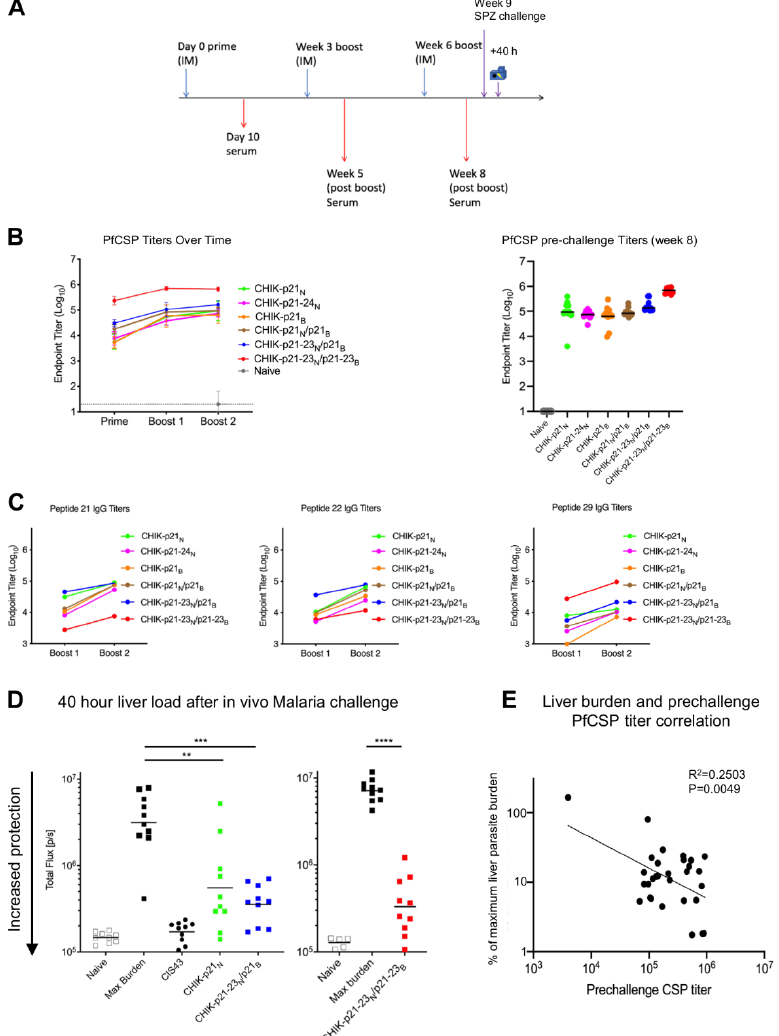
Figure 3. CHIK-VLP immunogens displaying CIS43 and L9 epitopes induced protection against malaria challenge. ( A ) Immunization and challenge schema. Blue arrows denote immunizations and red arrows denote blood draws. Liver burden was quantified 40 h post challenge. ( B ) Left: ELISA titers against PfCSP over time from pooled sera of each group. Right: PfCSP ELISA titers following Boost 2 (pre-challenge time point). ( C ) Serum ELISA titer against peptide 21, peptide 22, and peptide 29. ( D ) Liver burden following malaria challenge with Pb-PfCSP-GFP/Luc-SPZ. CIS43 indicates passively transferred CIS43 IgG, as a positive control. ** p < 0.01, *** p < 0.001, **** p < 0.0001 as calculated by two-tailed Mann– Whitney test. ( E ) Correlation of percent protection from malaria challenge with serum PfCSP ELISA.